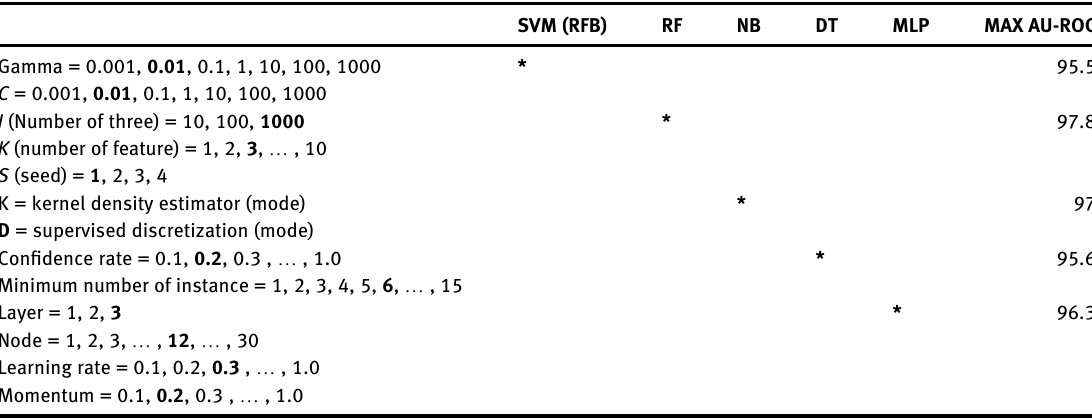
Table  : Investigatingtheresultofdifferentvaluesforparameterandsettingsonalgorithmperformance(boldnumbersindicates the value of parameters best performance in each